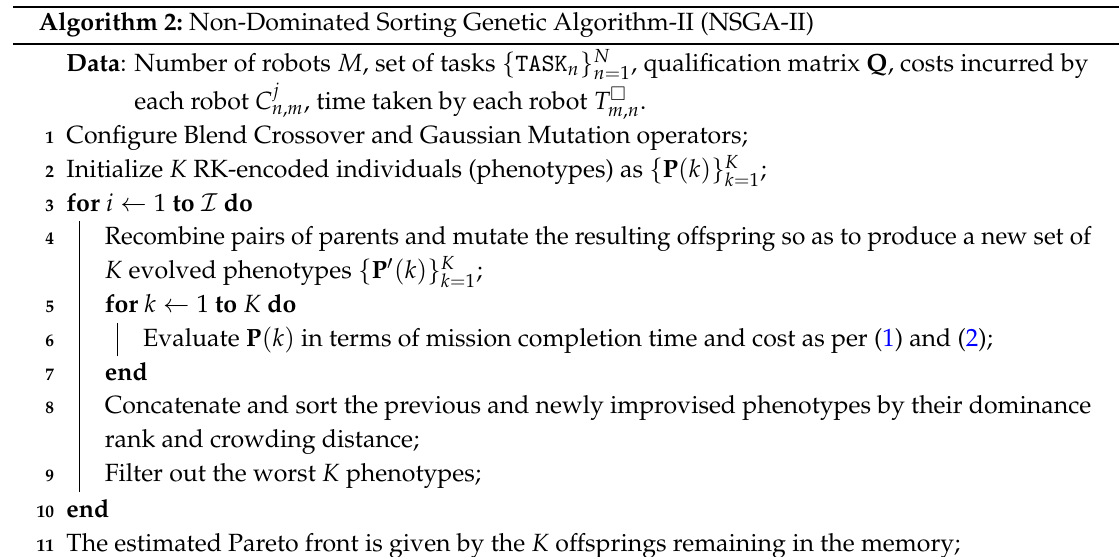
Algorithm 2: Non-Dominated Sorting Genetic Algorithm-II (NSGA-II)